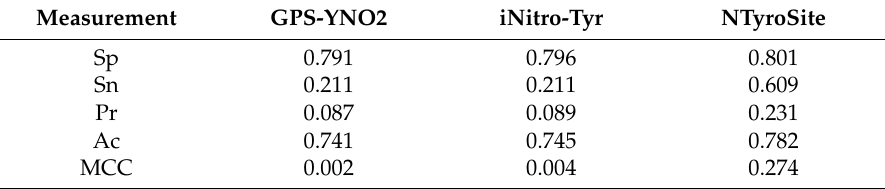
Table 3. Comparison of NTyroSite with existing predictors using an independent test set.